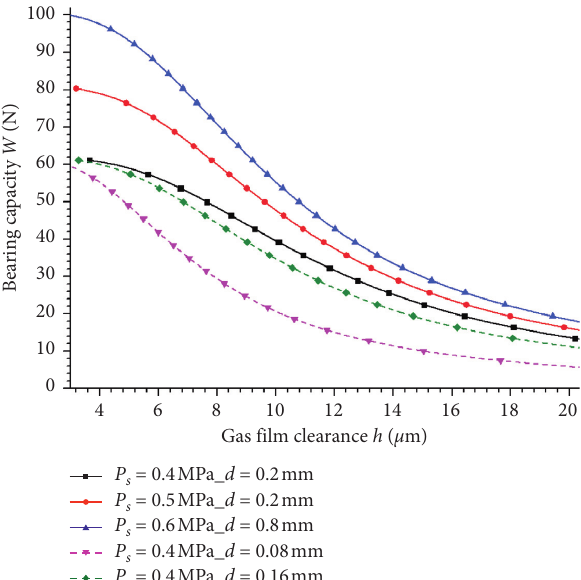
Figure 5: Change curve of bearing capacity.